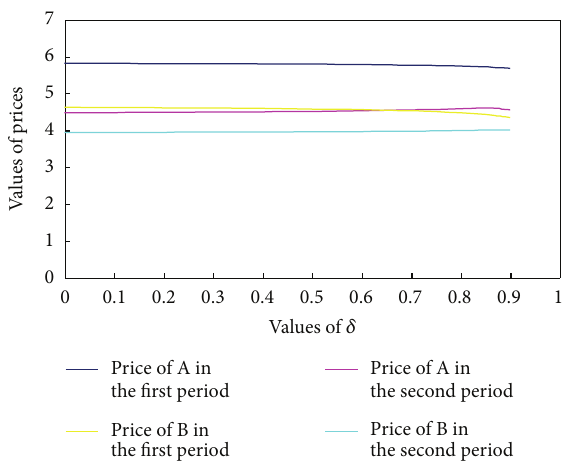
Figure 2: The sensitivity of optimal prices with respect to 𝜆